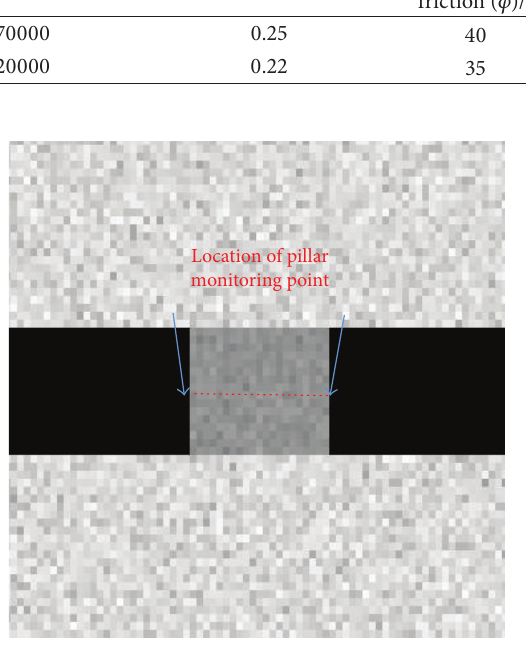
Figure 4: Location of stress and deformation monitoring